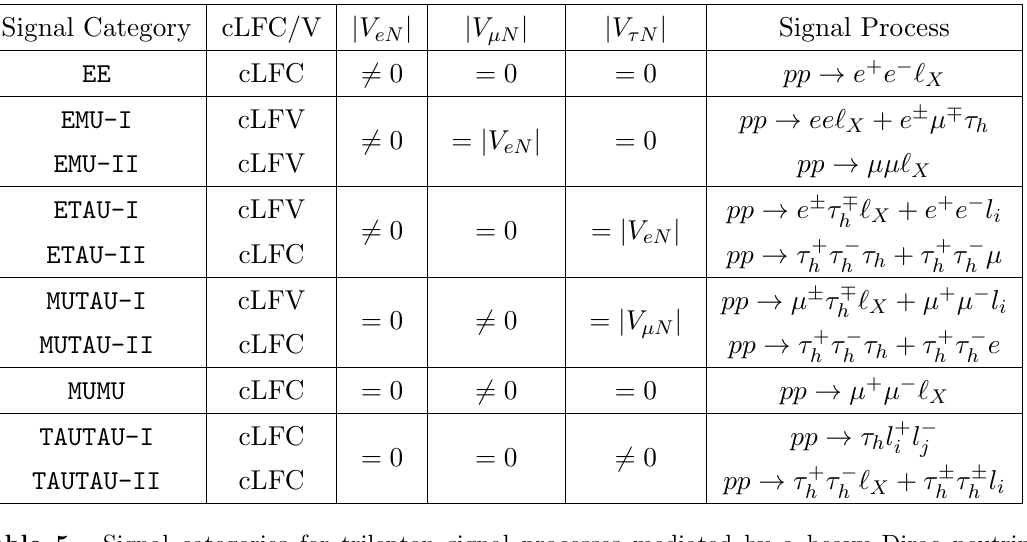
e; (cid:22); (cid:28) h , l i ; l j e; (cid:22) , and no indicates that both 2 f g 2 f g (cid:6)